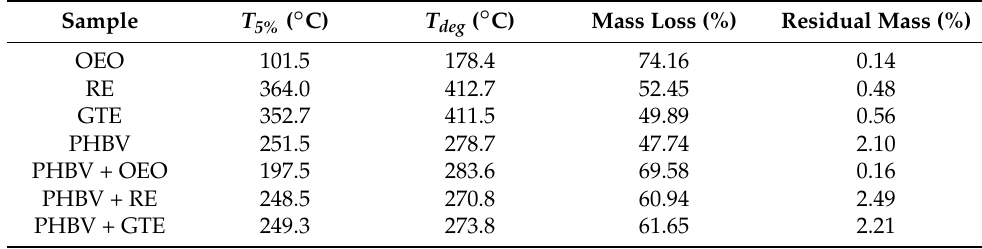
Table 3. Thermal properties of oregano essential oil (OEO), rosemary extract (RE), and green tea tree extract (GTE) and of the electrospun films of poly(3-hydroxybutyrate- co -3-hydroxyvalerate) (PHBV) containing OEO, RE, and GTE in terms of temperature at 5 % weight loss ( T 5% ), degradation temperature ( T deg ), and residual mass at 700 ◦ C.